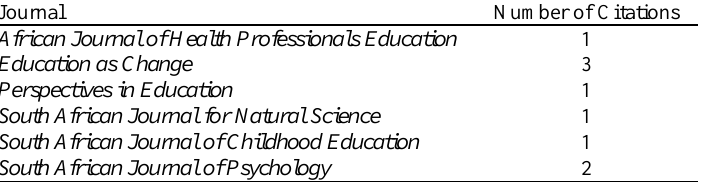
Table 5 South African journals in which self-citations are to be found from doctoral research completed in fields of education in South Africa in 2008